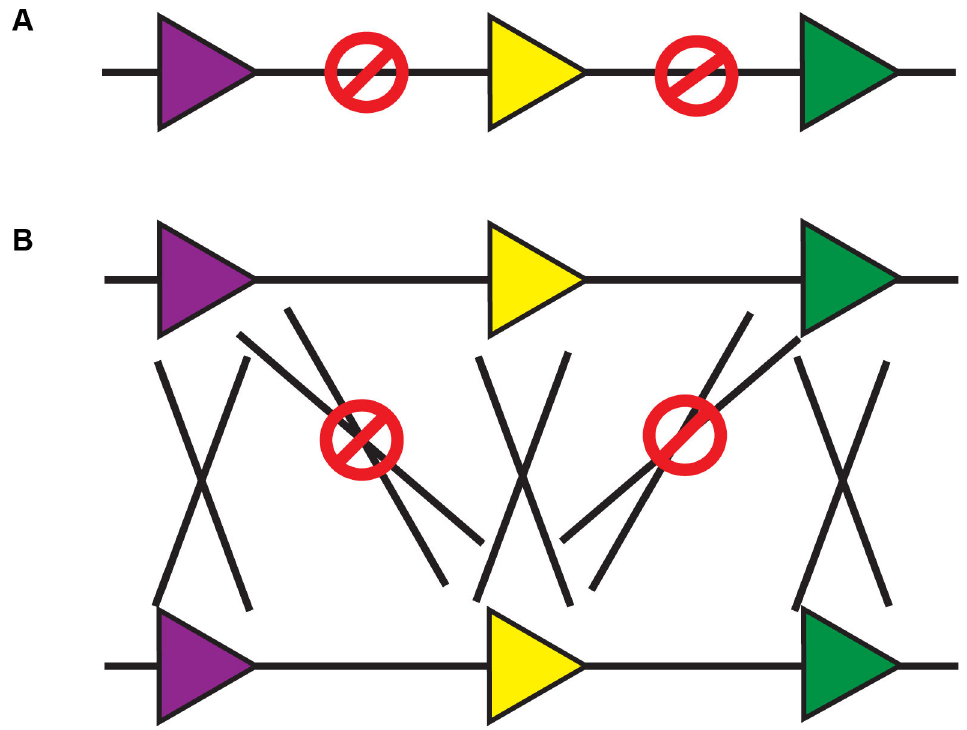
Figure 2. The design of MADM with multiple loxP sites (MADM-ML). (A) Mutually exclusive loxP sites (wildtype loxP and loxP variants lox2272 and lox5171) do not recombine with each other in cis . (B) These loxP variants recombine in trans , but only with their identical sites, but not with other